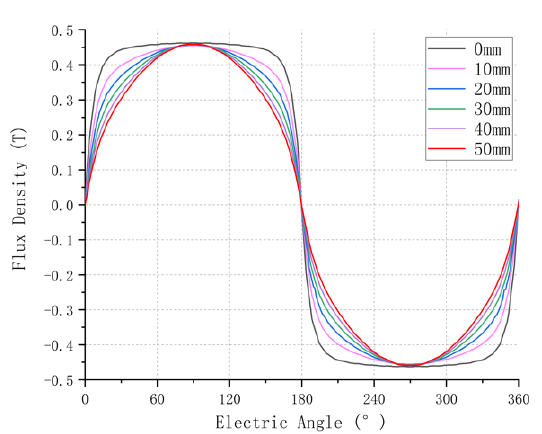
Figure 5. Air-gap magnetic field waveform with different eccentricity values.